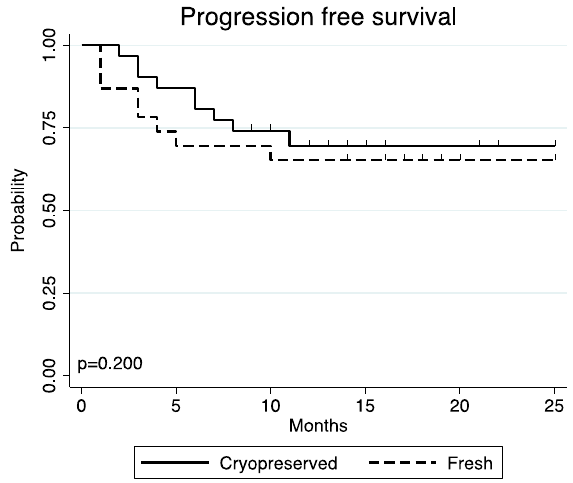
Figure 2. PFS in patients receiving cryopreserved vs. fresh